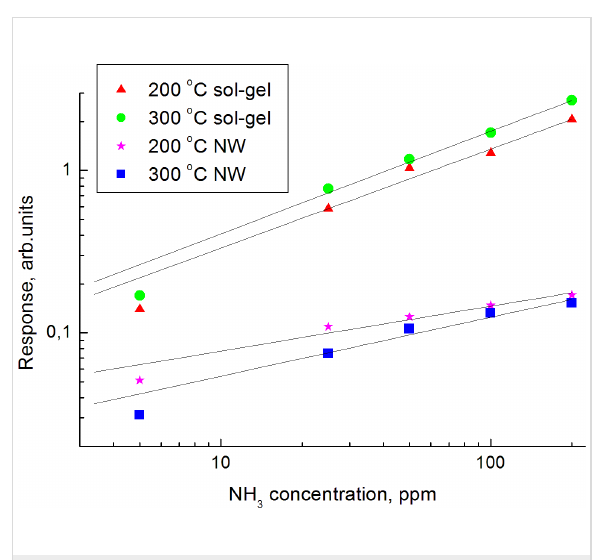
Figure 10: Calibration curves of the nanowire (NW) and sol–gel (nanopowder) sensors.